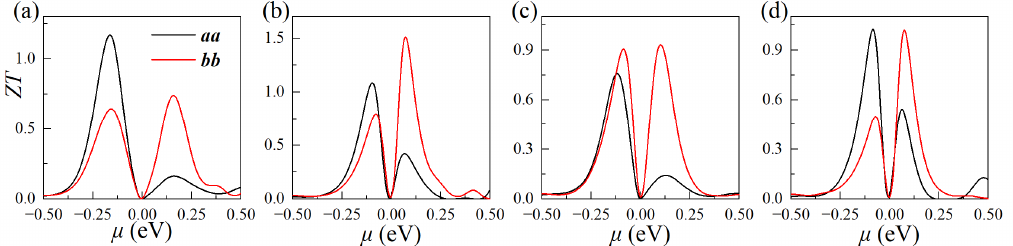
Figure 9. ZT values of the monolayer: ( a ) CuSbS 2 ; ( b ) CuSbSe 2 ; ( c ) CuBiS 2 ; and ( d ) CuBiSe 2 at 300 K.